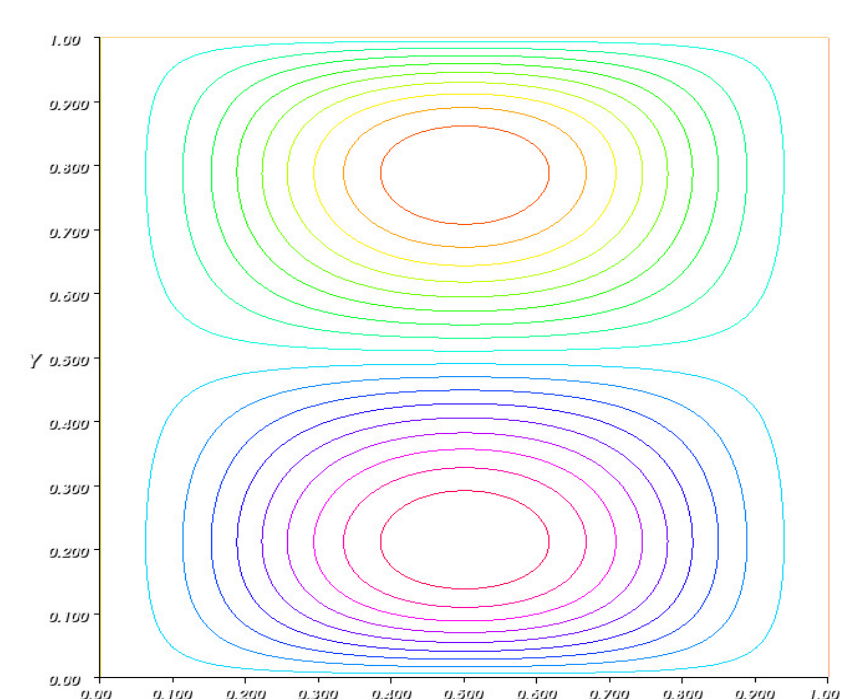
Figure 2. Fluid path or velocity